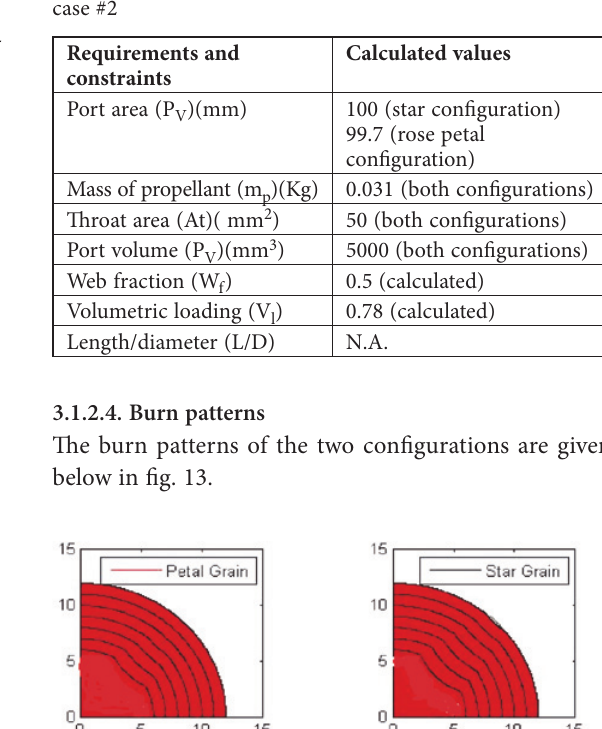
Table 3. Calculated values of requirements and constraints for